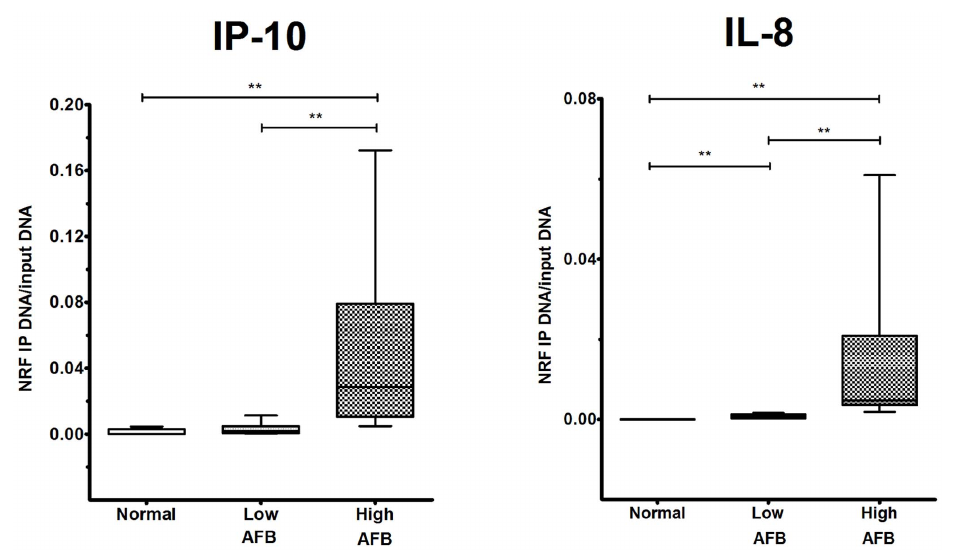
Figure 5. NRF binding to IP-10/CXCL10 and IL-8/CXCL8 promoter sites by ChIP assays. ChIP assays were performed on PBMC from active pulmonary TB patients and normal subjects by using a NRF antibody. The IP-DNA was quantified by q-PCR with primer pairs specific to IP-10/CXCL10 and IL-8/CXCL8 NRE sites at the promoters. Values were normalized by input DNA. The ChIP assays showed a higher binding of NRF to IP-10/CXCL10 (left panel) and IL-8/CXCL8 (right panel) promoter sites in TB patients with high bacterial load (High AFB, n=6) compared to those of TB patients with low bacterial load (Low AFB, n=6) or normal subjects (Normal, n=5). Data are means 6 SE. ** p , 0.01.